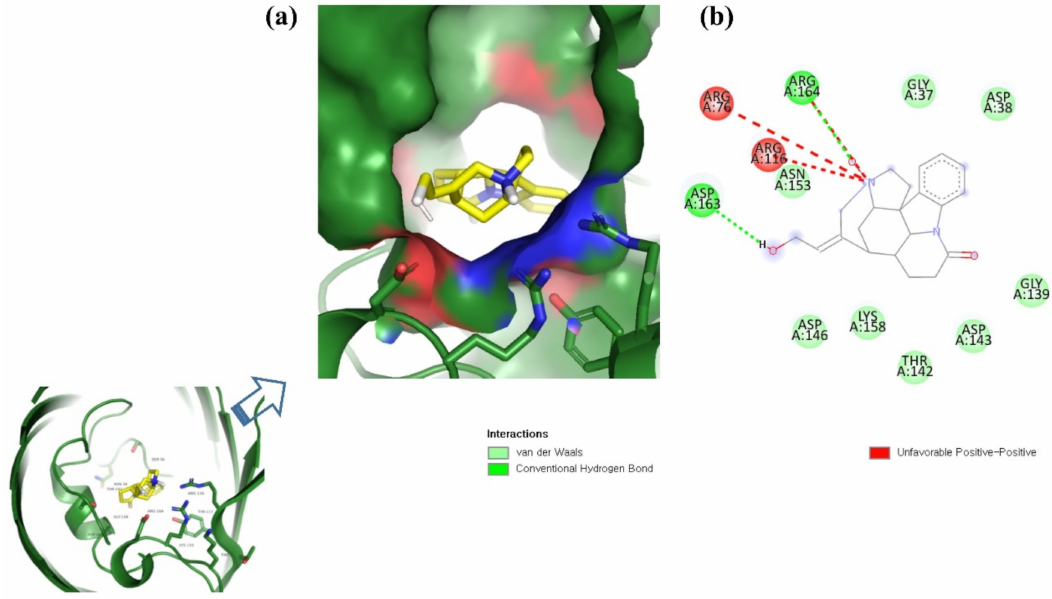
Figure 3. Visualization of ZINC85510056 in the binding pocket of OmpU ( a ); 2D view of residues of OmpU interacting with ZINC85510056 ( b